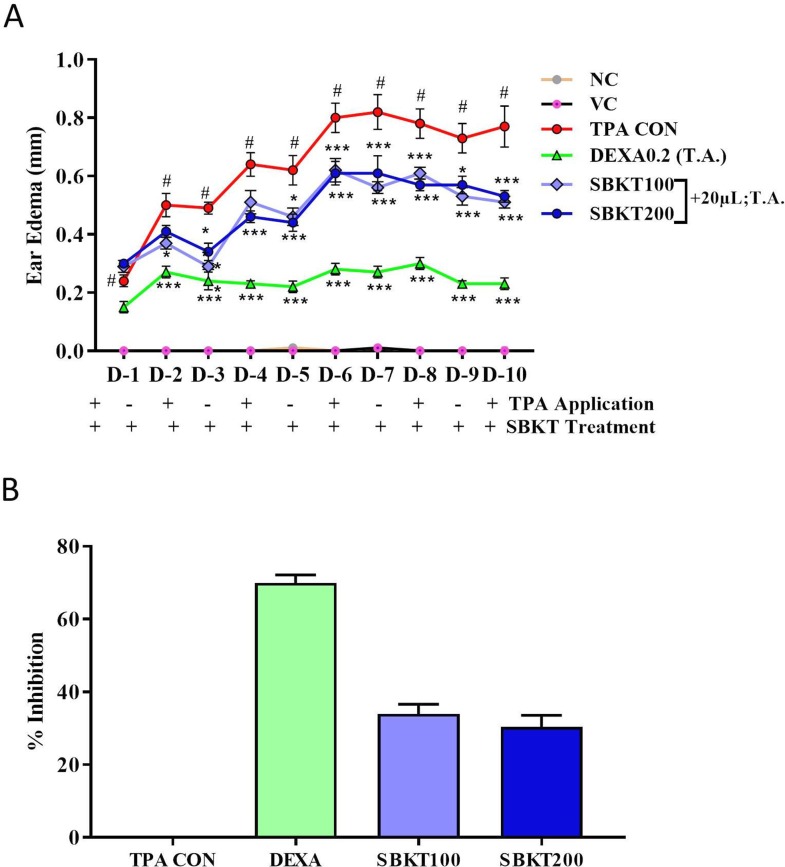
Effect of SBKT on TPA-induced ear edema in mice. (A) Co-treatment of the TPA-stimulated psoriatic ear (TPA CON) with SBKT (100 and 200 mg/kg; p.o. and 20 μl T.A.) or with DEXA (0.2 mg/ear; T.A.) significantly reduced ear edema. (B) Represents percent ear edema inhibition (activity) calculated in comparison to TPA CON animals at D10. This panel represents % inhibition (activity) of SBKT 100, SBKT 200, and DEXA individually. Statistical analysis was performed using two-way ANOVA followed by Newman–Keuls multiple comparison test (n = 8 animals). #p < 0.001 (NC versus TPA CON); NS p > 0.05 (NC versus VC) *p < 0.05, **p < 0.01, ***p < 0.001 (TPA CON versus SBKT; TPA CON versus DEXA). NC, normal control; VC, vehicle control; TPA CON, 12-O-tetradecanoyl phorbol-13-acetate; DEXA, dexamethasone; SBKT, sea buckthorn oil.